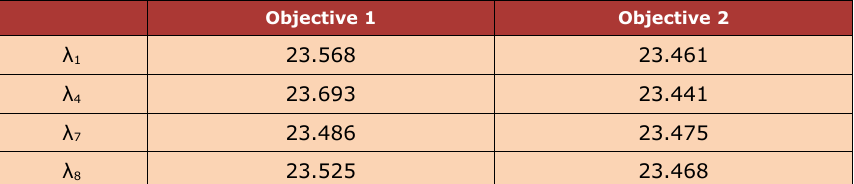
Table 8. Objective values for selected